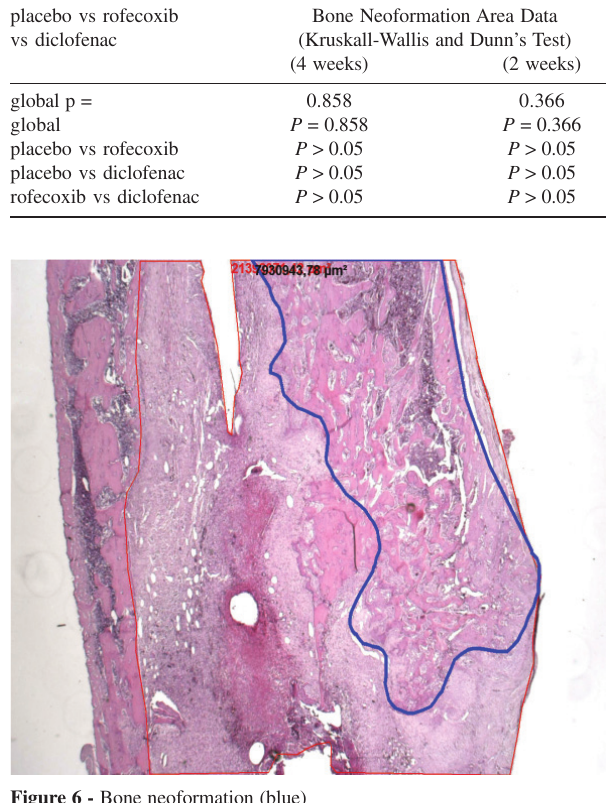
Table 3 - Intergroup comparison of bone neoformation area among the groups with at 4 and 2 weeks after osteotomy placebo vs rofecoxib Bone Neoformation Area Data vs diclofenac